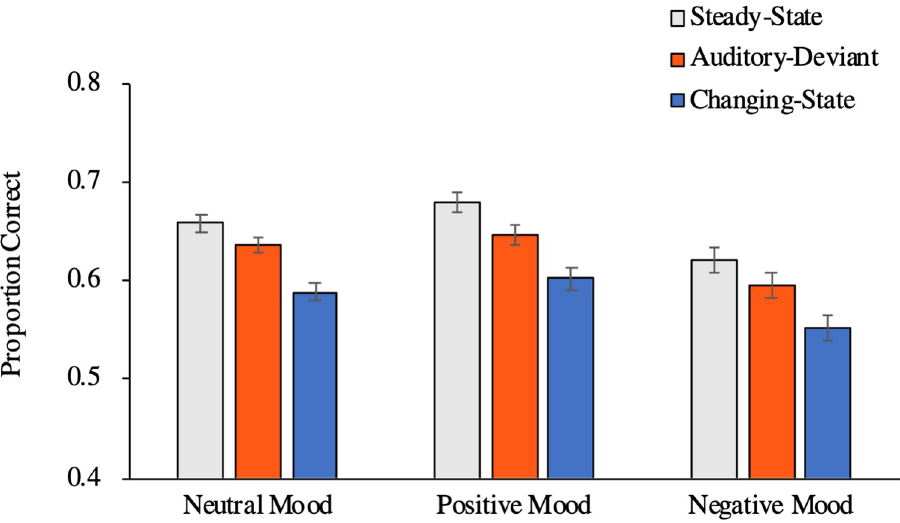
Fig 5. Proportion of correct responses in serial recall for the combined data of all four experiments. The proportion of correct responses is presented as a function of distractor condition and valence of induced mood. The error bars represent the standard errors of the